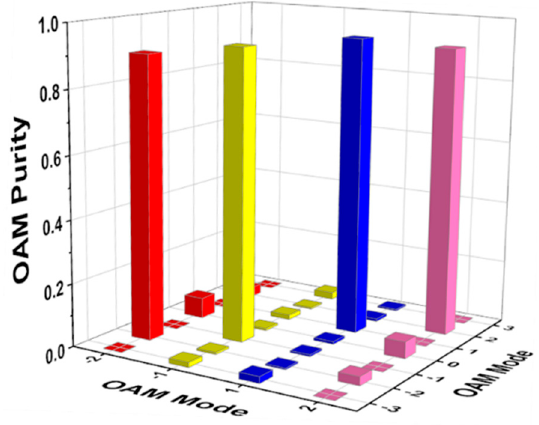
Figure 12. The OAM purity of vortex beams at 1 THz.